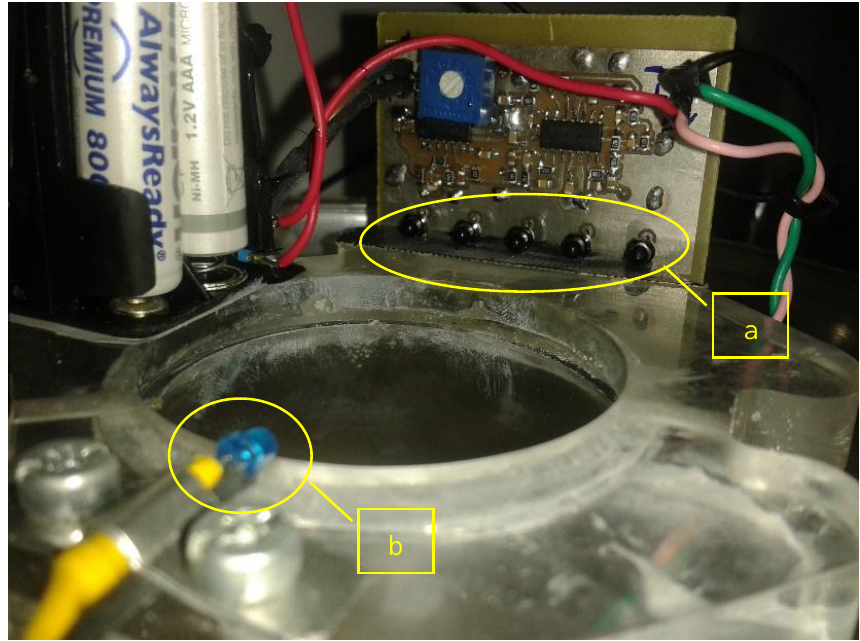
Figure 3. Optoelectronic sensor embedded in the trap. ( a ) the array of phototransistors. A black tape is inserted underneath the phototransistors to cut reflections ( b ) the LED infrared source (blue bulb).